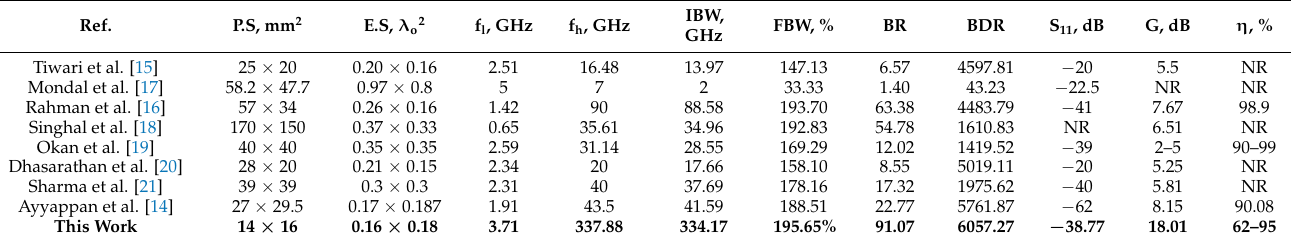
Table 4. Comparison to the reported SWB antenna structures.